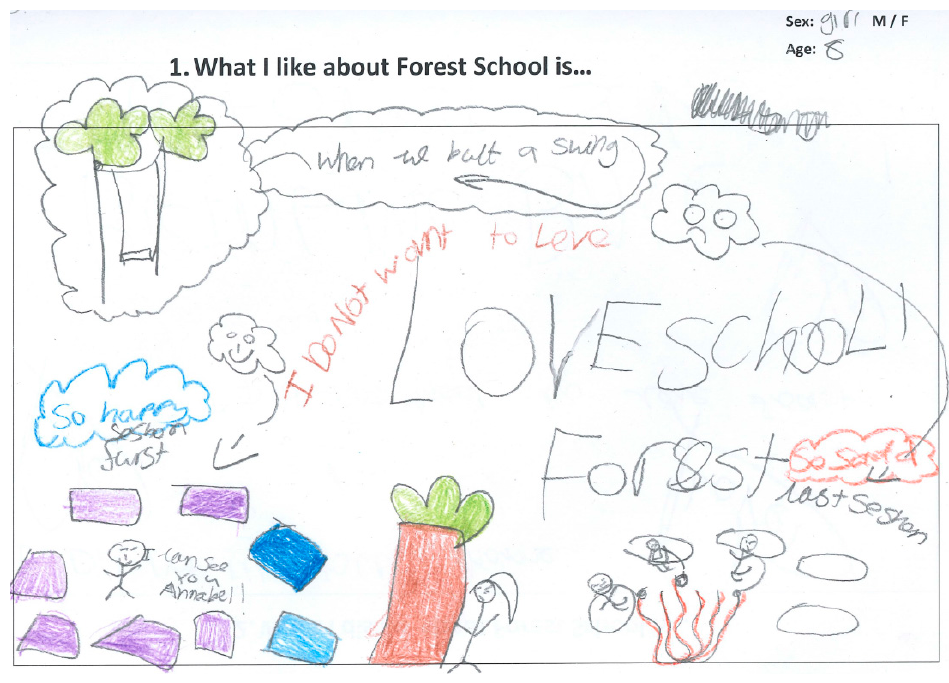
Figure 3. Drawing to illustrate girls’ likes.